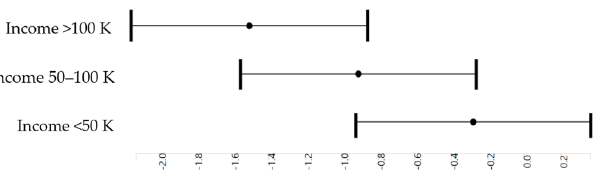
Figure 1. The association between family income and children’s screen time overall.